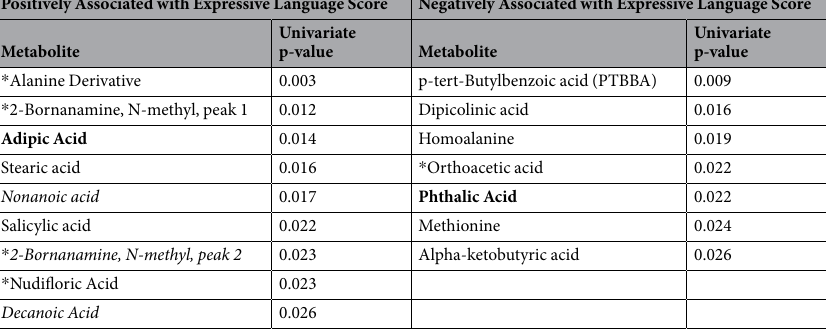
Table 3. Identified metabolites achieving q < 0.15 for the relationship with expressive language, and meeting the missing value criteria. Asterisks denote tentative identifications (library match between 60% and 75%). P-values are from the single metabolite analyses controlling for demographic factors. Bolded compounds were selected in the multivariate model; other compounds correlated to these selected compounds with |r| > 0.5 are